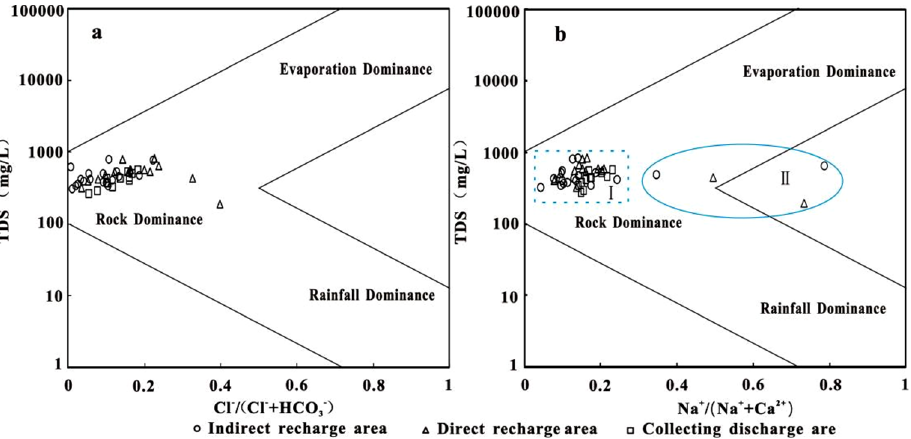
Figure 3. Gibbs diagram of karst water samples in the Baotu karst spring system (( a ) Cl − /(Cl − + HCO 3 − ) and ( b ) Na+/(Na + + Ca 2+ ).